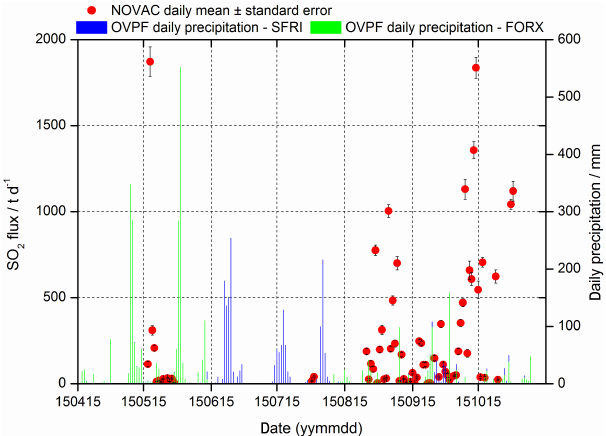
Figure 6. Estimated daily mean SO 2 emission (td − 1 ) obtained by integrating the DOAS plume scans with the wind speed provided by Météo-France (Bellecombe station). Daily precipitations are from the SFRI and Châteaufort (FORX) stations of OVPF located respec- tively at the top and at the SE base of the central